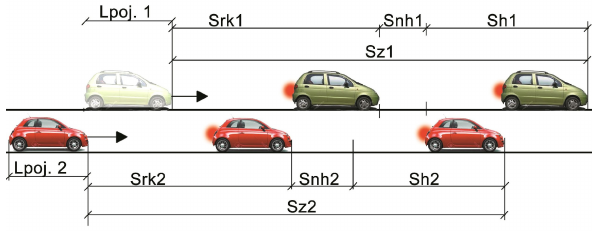
Figure 3: Situation diagram for three components of the length of the vehicle stopping distance with cars shifted in phase by the value of the first length